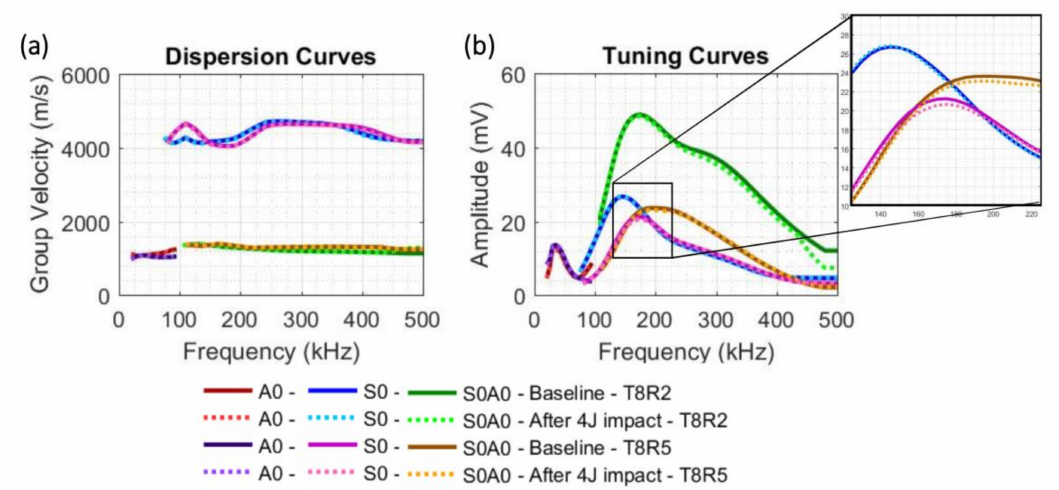
Figure 8. ( a ) Dispersion and ( b ) tuning curves comparison between the baseline and signals acquired after a 4J impact in the middle of the T-joint, for signals generated from transmitter ‘T8’ and received by receivers ‘R2’ (path on skin) and ‘R5’ (path on